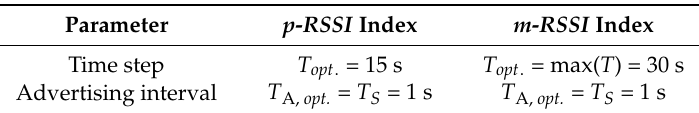
Table 2. Optimal advertising parameters.